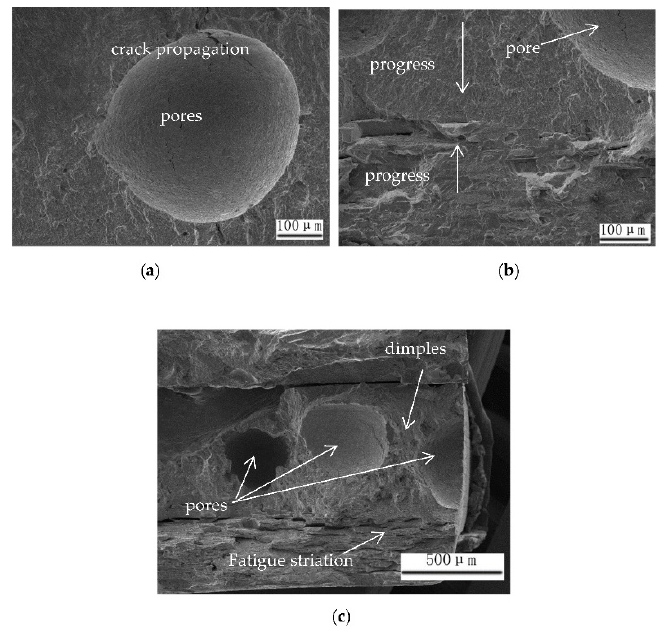
Figure 7. The SEM photographs of fracture of sample 1–8 fatigue cycle is 111,962. ( a ) crack initiation zone, ( b ) crack propagation zone, ( c ) final fracture zone.